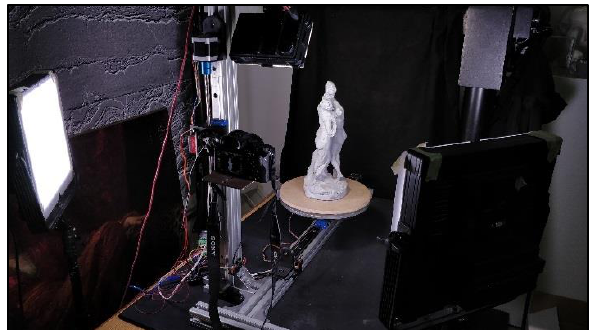
Figure 5. Test setup, three diffused lights